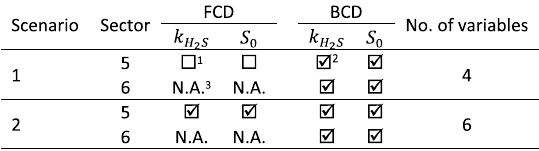
Table 6 H S modeling optimization variables in each scenario 2